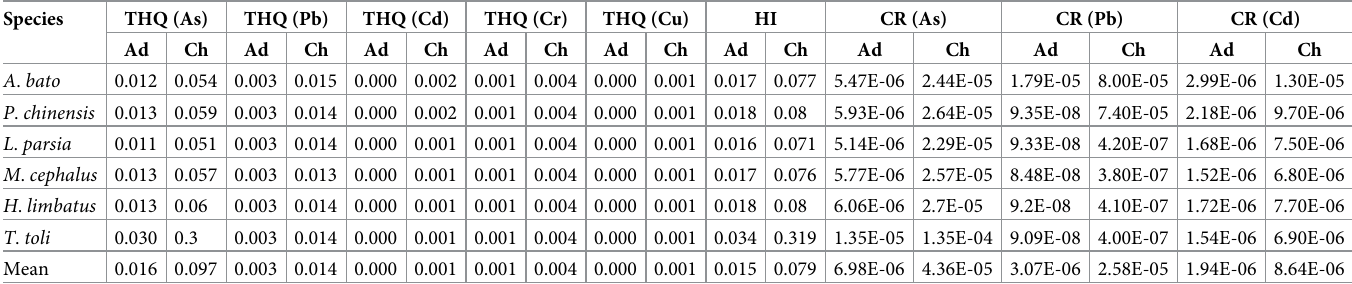
Table 6. Calculated THQ, HI and CR for the selected two aged